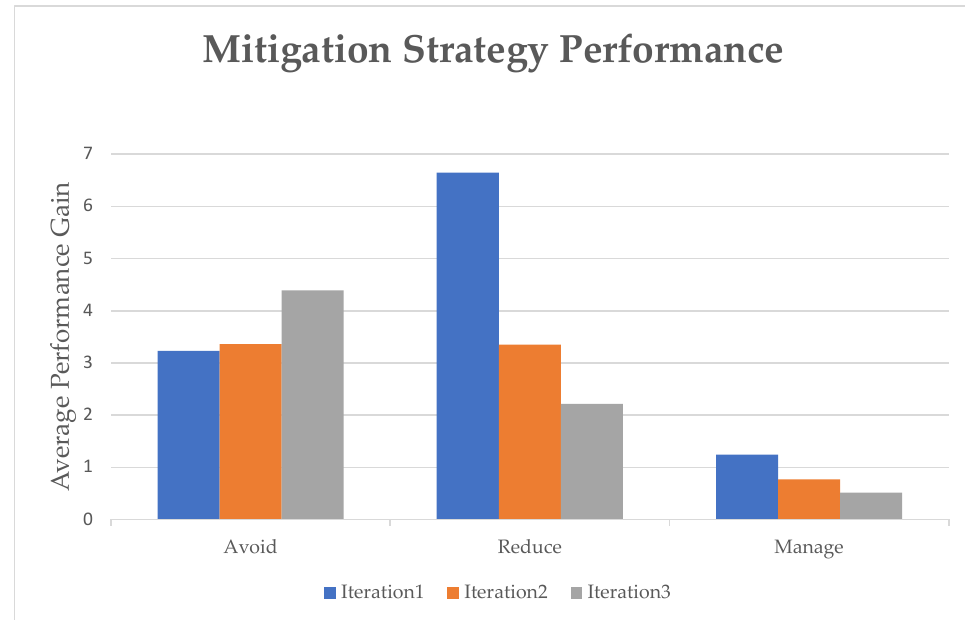
Figure 9. The efficiencies of the various strategy types for case study 2.